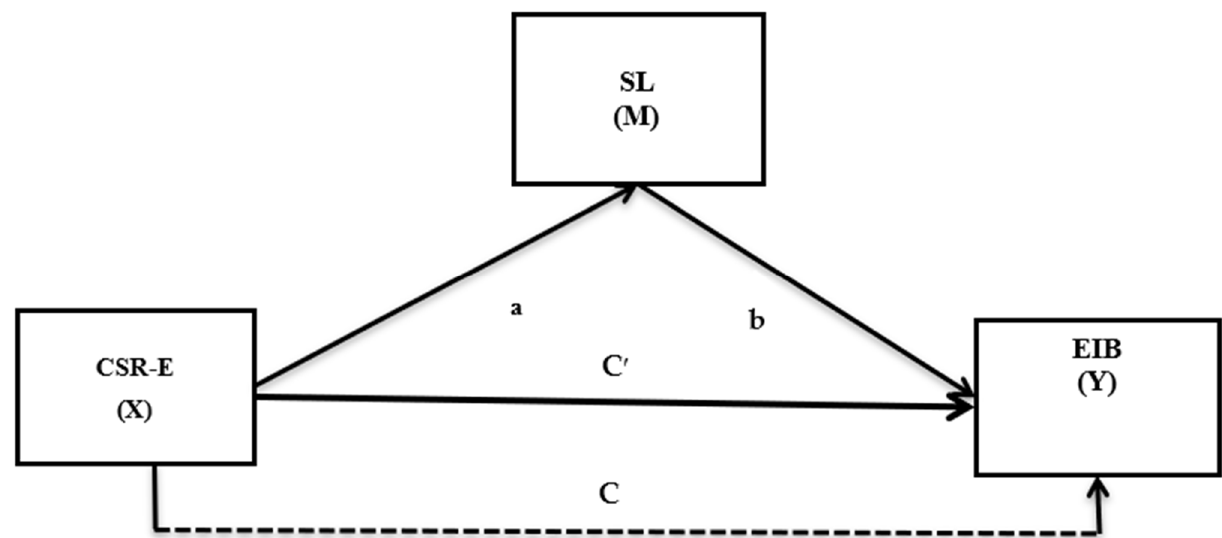
Figure 1. The proposed research model, based on the authors’ conception. This model comprises three variables, corporate social responsibility at the employee level (CSR-E) = the independent variable (X), servant leadership (SL) = the mediating variable (M), and employee innovative work behavior (EIB) = the dependent variable (Y).